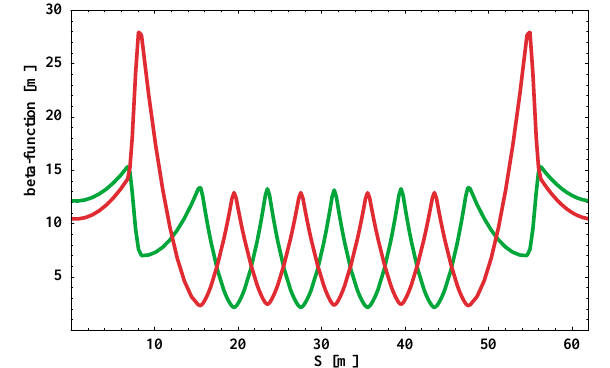
FIG. 18. (Color) Horizontal (red) and vertical (green) beta func- tions of the SNS lattice with (cid:3) n 0 x , n 0 y (cid:4) (cid:1) (cid:3) 6.23, 6.20 (cid:4) for one